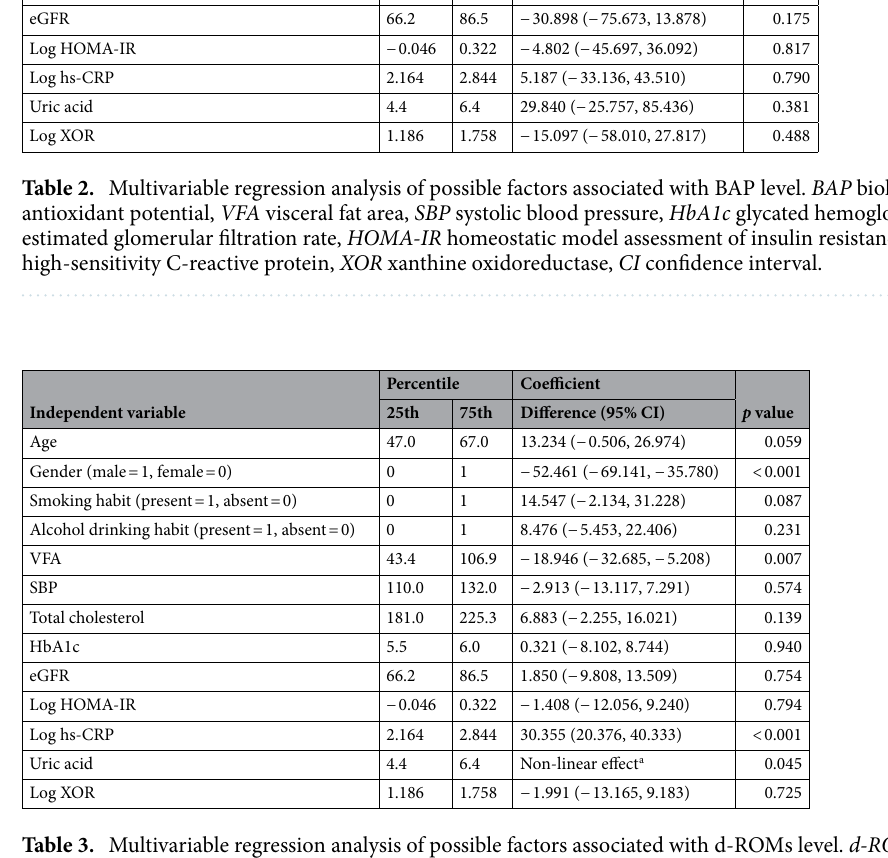
Table 3. Multivariable regression analysis of possible factors associated with d-ROMs level. d-ROMs derivative of reactive oxygen metabolites, VFA visceral fat area, SBP systolic blood pressure, HbA1c glycated hemoglobin, eGFR estimated glomerular filtration rate, HOMA-IR homeostatic model assessment of insulin resistance, hs-CRP high-sensitivity C-reactive protein, XOR xanthine oxidoreductase, CI confidence interval. a See Fig.